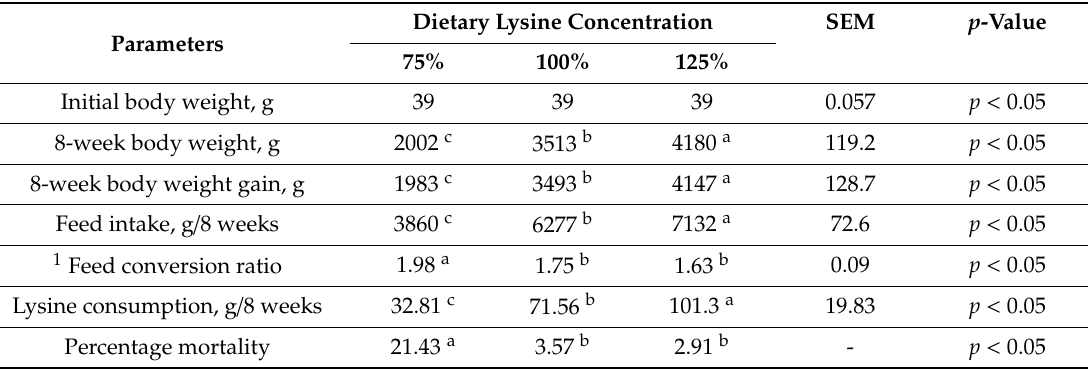
Table 1. Effects of dietary lysine concentration on the growth performance of broiler chickens during the 8-week period.